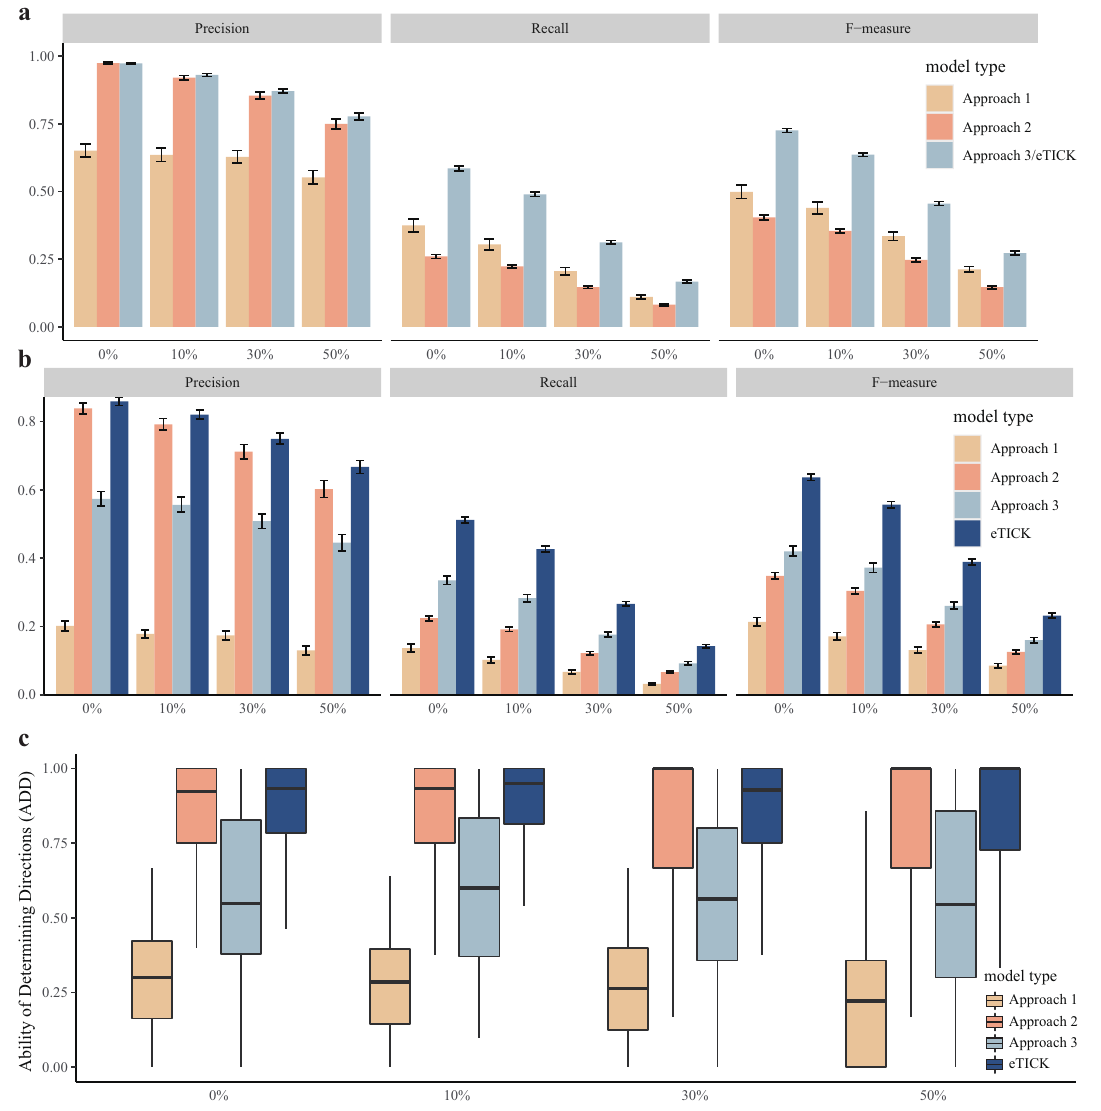
Figure 4. Results of single-trace simulation with latent variables. ( a ) The performance of discovering edges of all approaches with different proportions of latent variables. ( b ) The performance of determining directions of all approaches with different proportions of latent variables. ( c ) The ADD of all approaches with different proportions of latent